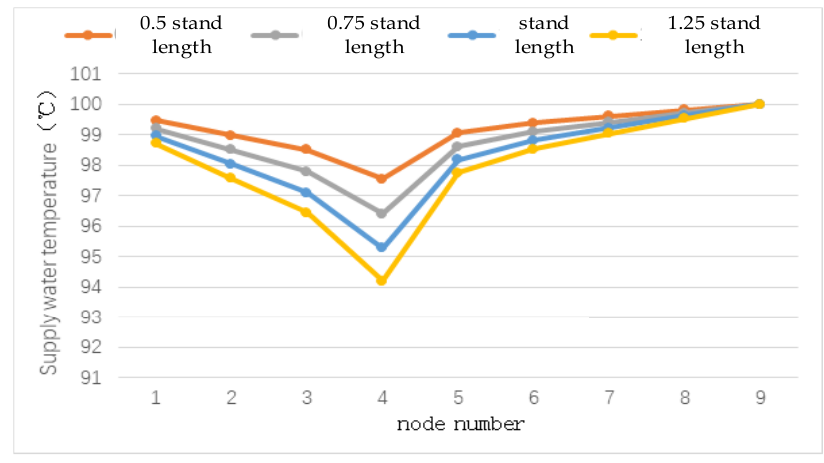
Figure 12. Supply water temperature of all nodes under different pipeline lengths.